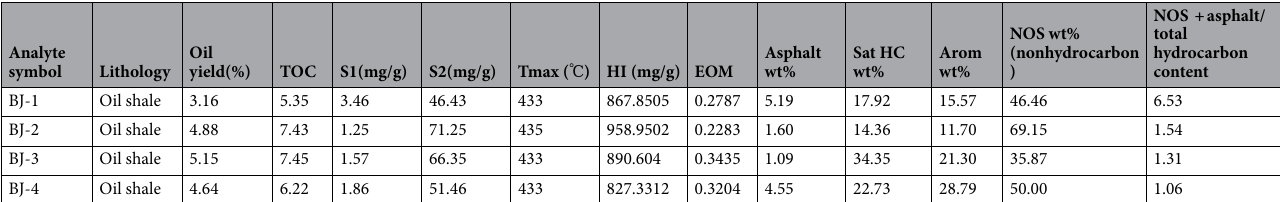
Table 3. Organic geochemistry data of the oil shale samples in Bayanerhet